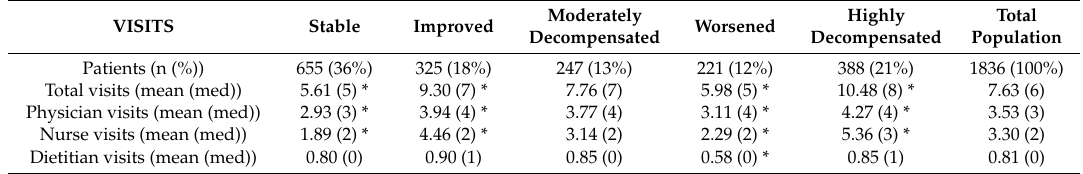
Table 3. Patients and visits for each discipline by segments and total